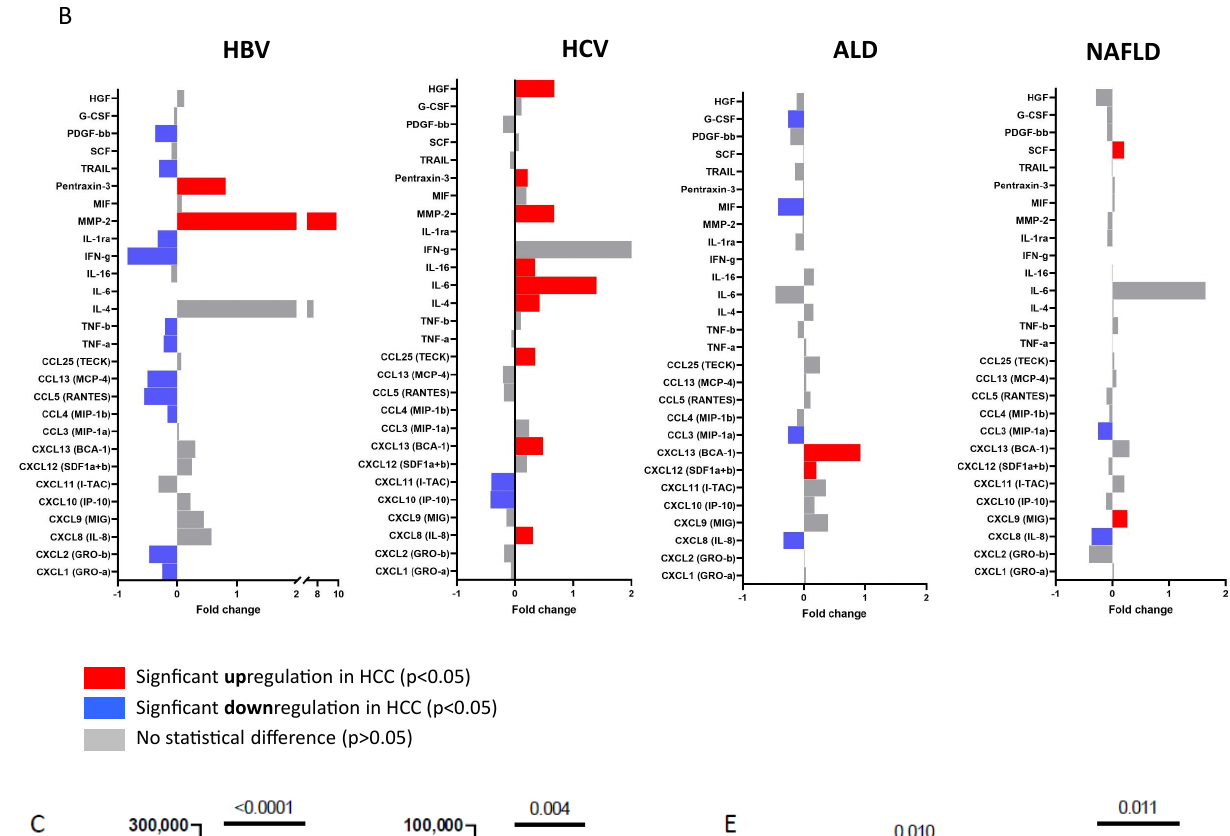
Sign fi cant up regula �on in HCC (p<0.05) Sign fi cant down regula �on in HCC (p<0.05) No sta � s � cal di ff erence (p>0.05)